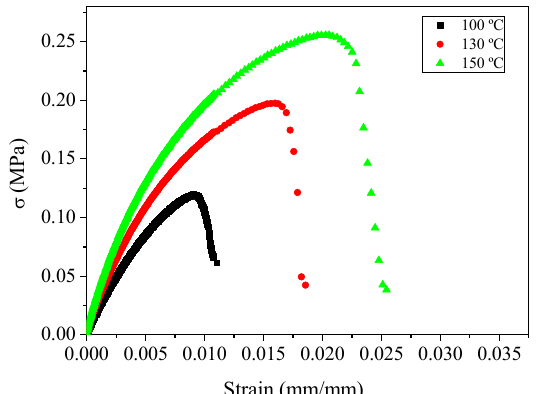
Figure 3. Stress–strain curves obtained from tensile tests for the bioplastics obtained for different mould temperatures (100, 130 and 150 ° C).